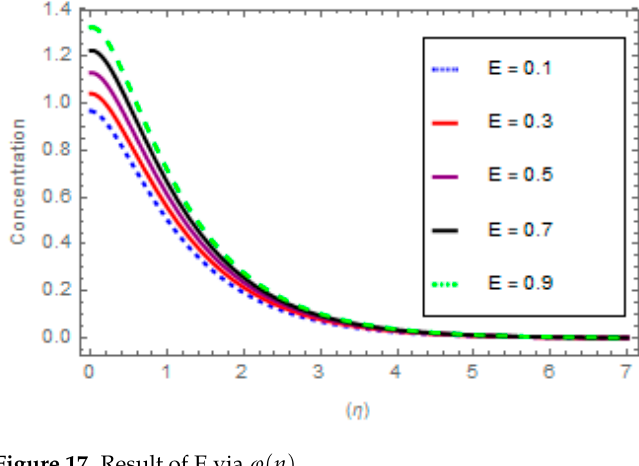
Figure 17. Result of E via ϕ ( η ) .